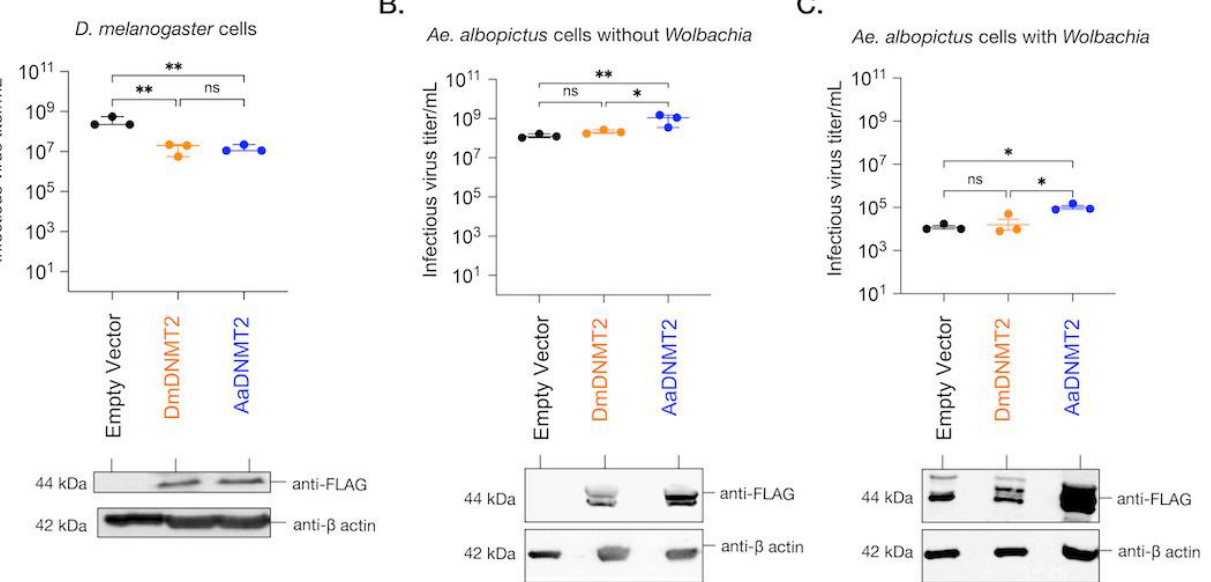
Figure 5. The effect of DNMT2 orthologs on virus replication is host-dependent. ( A ) Drosophila melanogaster -derived JW18 cells (without Wolbachia ) were transfected with plasmid constructs expressing epitope (FLAG)-tagged versions of either the native fly ( Dm DNMT2, depicted in orange) or the non-native mosquito ( Aa DNMT2, depicted in blue) orthologs. Empty vector carrying only the FLAG tag was used as a negative control (depicted in black). At 72 h post-transfection, JW18 cells expressing either the empty vector, the native DNMT2 ( Dm DNMT2), or the non-native DNMT2 ( Aa DNMT2) were challenged with SINV at MOI of 10 particles/cell. Cell supernatants were collected 48 h post-infection, and infectious virus production was assessed via standard plaque assays on mammalian fibroblast BHK-21 cells. One-way ANOVA with Tukey’s post hoc test for multiple comparisons: empty vector vs. Dm DNMT2: p = 0.0016, empty vector vs. Aa DNMT2: p =